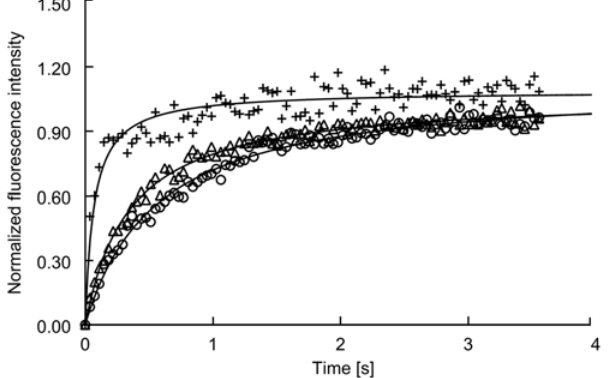
Figure 4. FRAP curves of NBD-cholesterol in SM-/SLPE-/DPPE- based liposomes. Normalized fit curves represent the average values of 10 independent FRAP measurements for each liposome mixture containing 1 mol% NBD-Cholesterol.( # ) SM/Ch/DOPC, ( D ) SLPE/Ch/ DOPC and DPPE/Ch/DOPC (1:1:0.2 molar ratio).